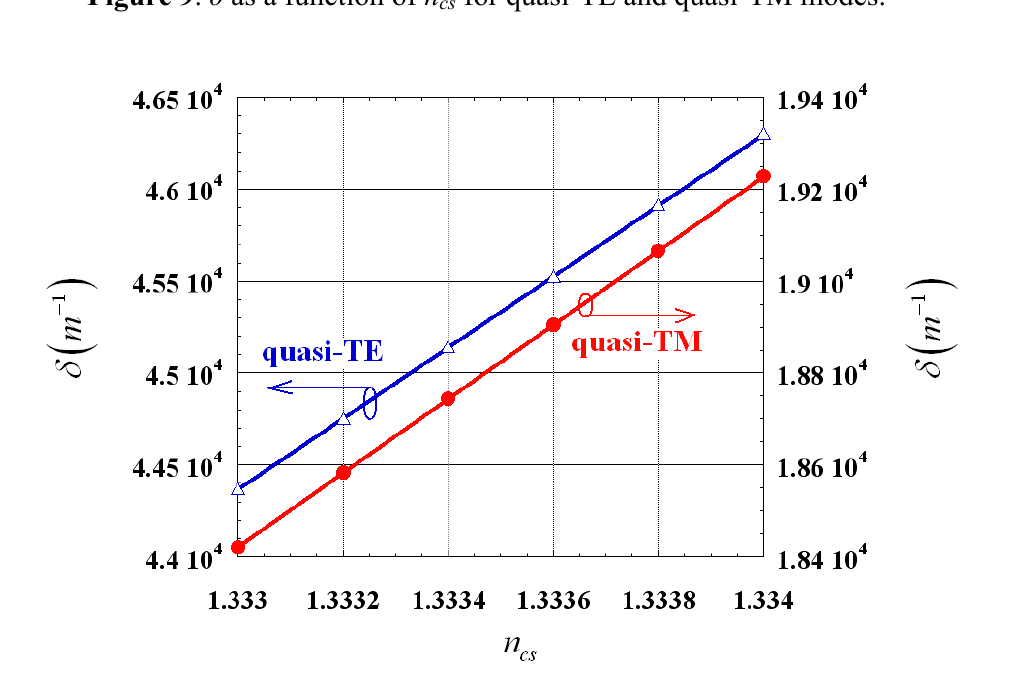
Figure 9 . δ as a function of n